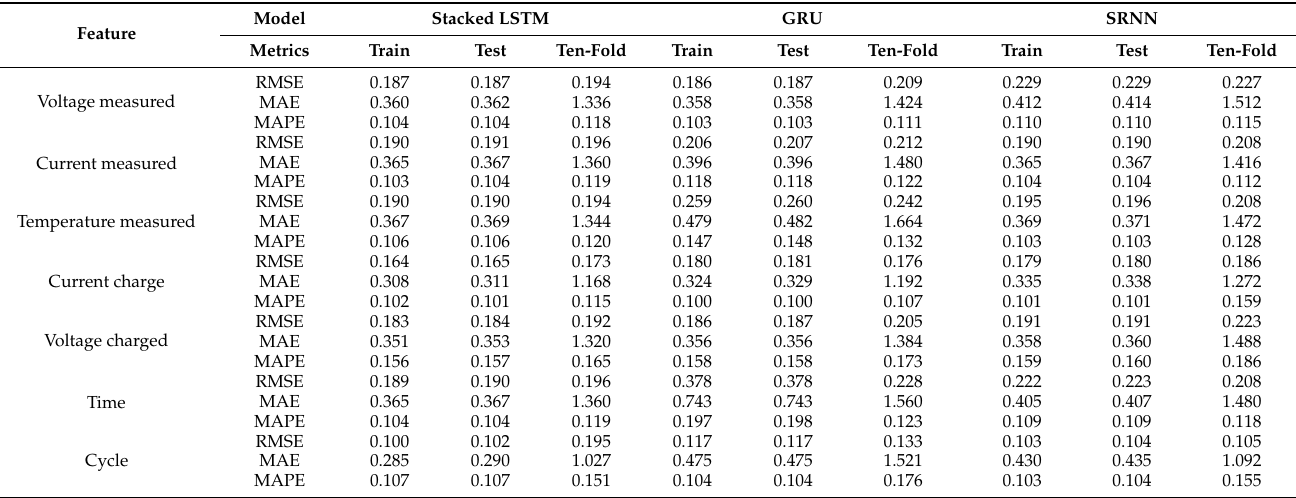
Figure 14. ( a – c ) Actual vs. predicted results with Jellyfish optimized Ex-AI features. Table 5. Prediction results with individual